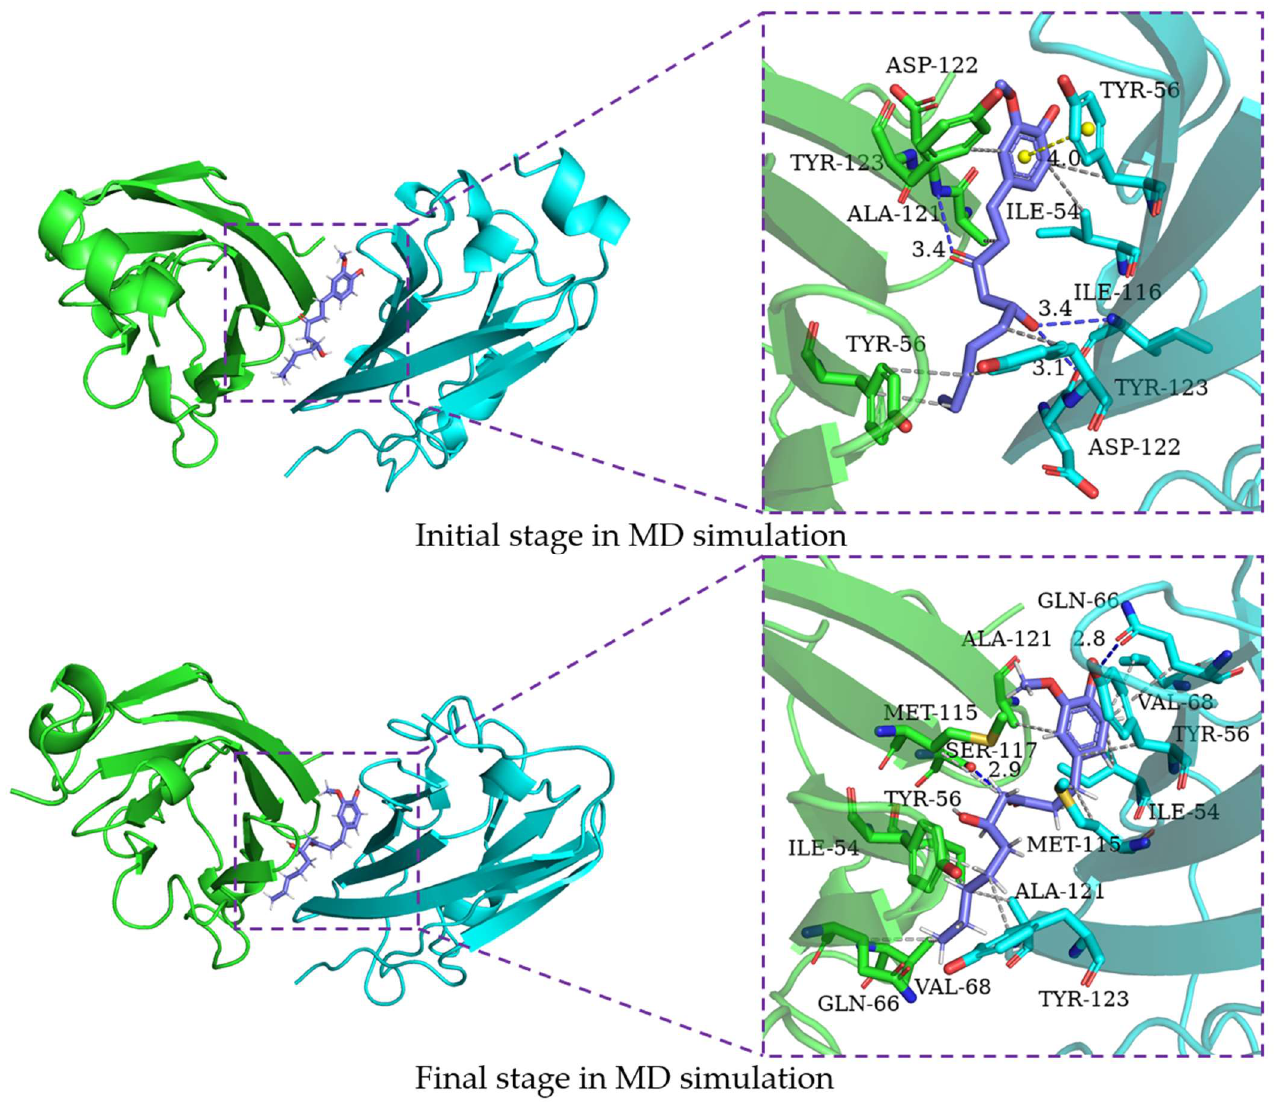
Figure 8. The interaction of 6-gingerol and residues of the binding site at 0 ns and 200 ns; the key residues on (A)PD-L1 and (B)PD-L1 are shown as green and cyan sticks, respectively, while the ligands are shown as purple sticks. Hydrophobic interactions, H-bonds and Π -stacking are shown as gray, blue and yellow dashes,